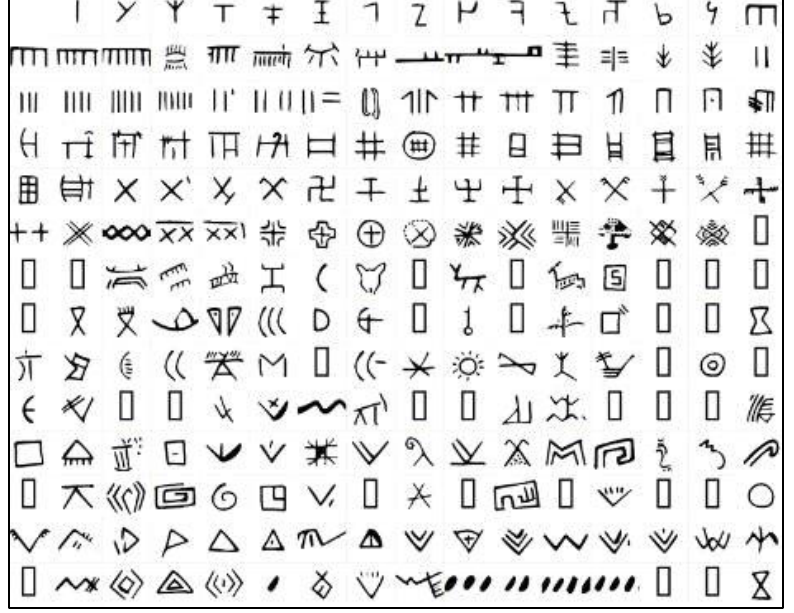
Figure 4. The Vinča Symbols